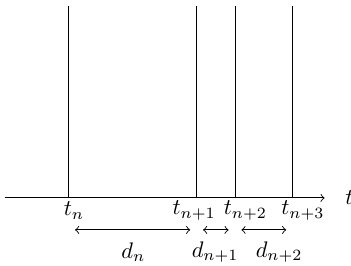
Fig. 1. Scheme of the durations received (each vertical bar represents a photon). t n is the arrival time of the n th photon and d n = t n +1 (cid:2) t n . We de fi ne a random bit from the sign of d n (cid:2) d m for suf fi ciently different values of n and m to avoid correlations between arrival times.